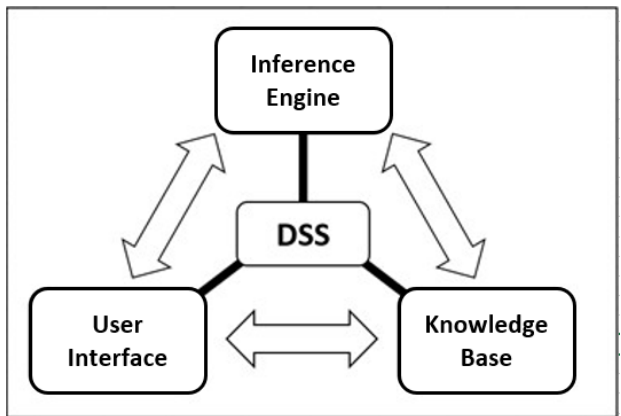
Figure 1. The three key components of a DSS: the user interface, the inference engine, and the knowledge database.